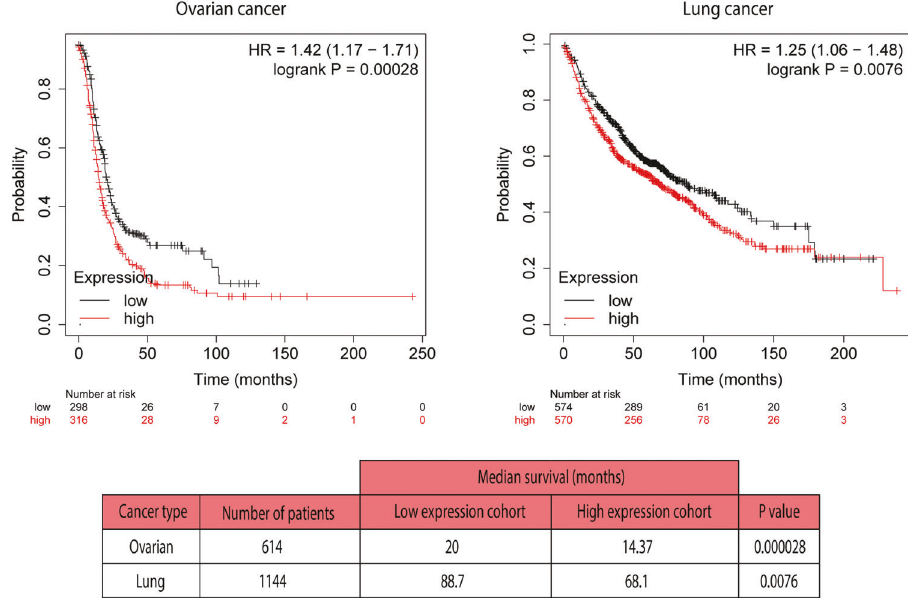
Fig. 1 Kaplan – Meier analysis. Overall survival rate for patients expressing low or high CPT1C mRNA levels (614 and 1144 patients with ovarian cancer and lung cancer, respectively) analyzed with Kaplan – Meier plotter. Dataset and analysis system from